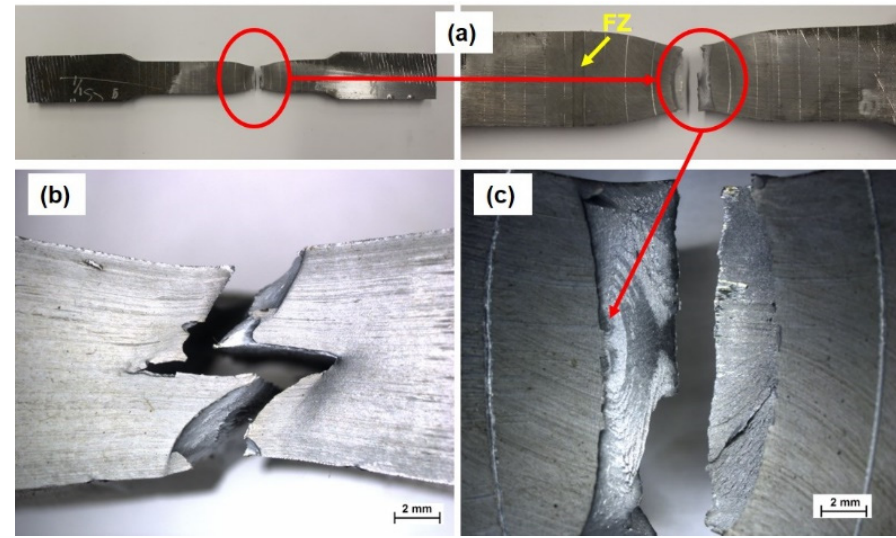
Figure 9. Tensile test specimen. ( a ) fractured sample; ( b ) side view of fractured section; ( c ) front view. The comparative tensile test results of EBW and GMAW joints are given in Table